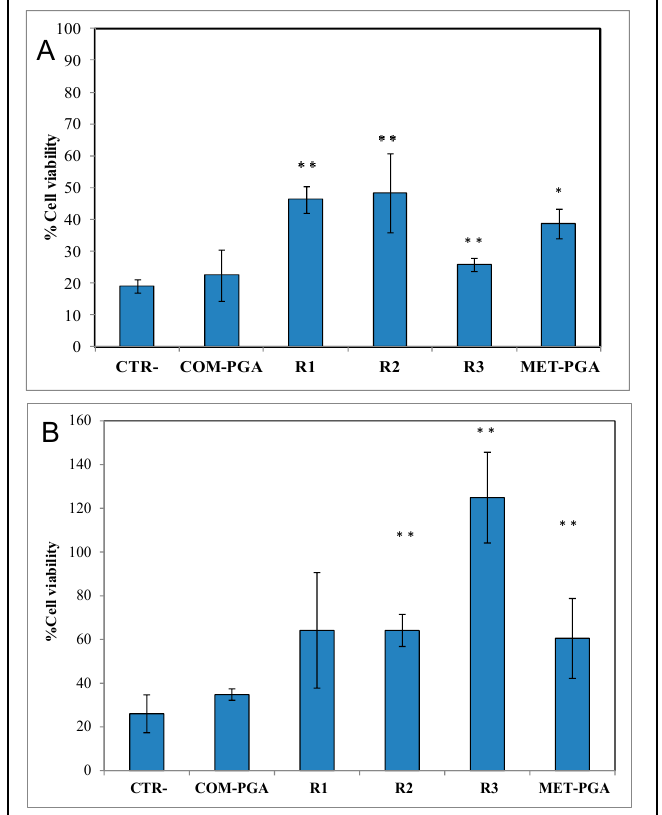
Figure 4. Dehydration assay ( A ) and oxidative stress assay ( B ) on HaCat cells as rescue effect of COM-PGA, MET-PGA and of γ -PGA-containing R1, R2 and R3 fractions, normalized over the positive control and compared to the negative control. (Statistical analysis: * p < 0.05 and ** p < 0.01 compared to the negative control).